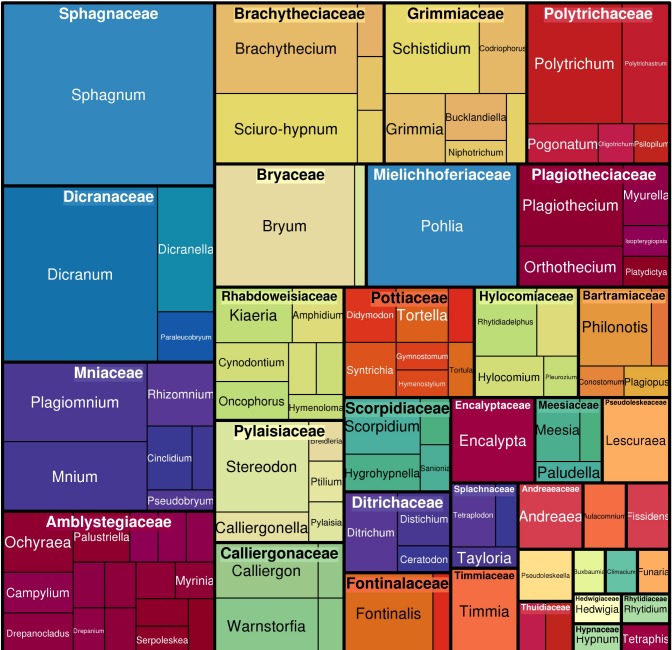
Taxonomic distribution of species amongst moss families in the dataset. The figure was prepared with the “treemap” package in R (Tennekes 2017)